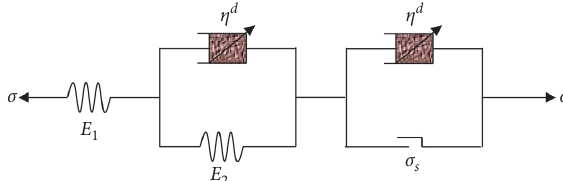
Figure 15: Schematic diagram of the improved Nishihara model based on fractional derivatives theory with damage